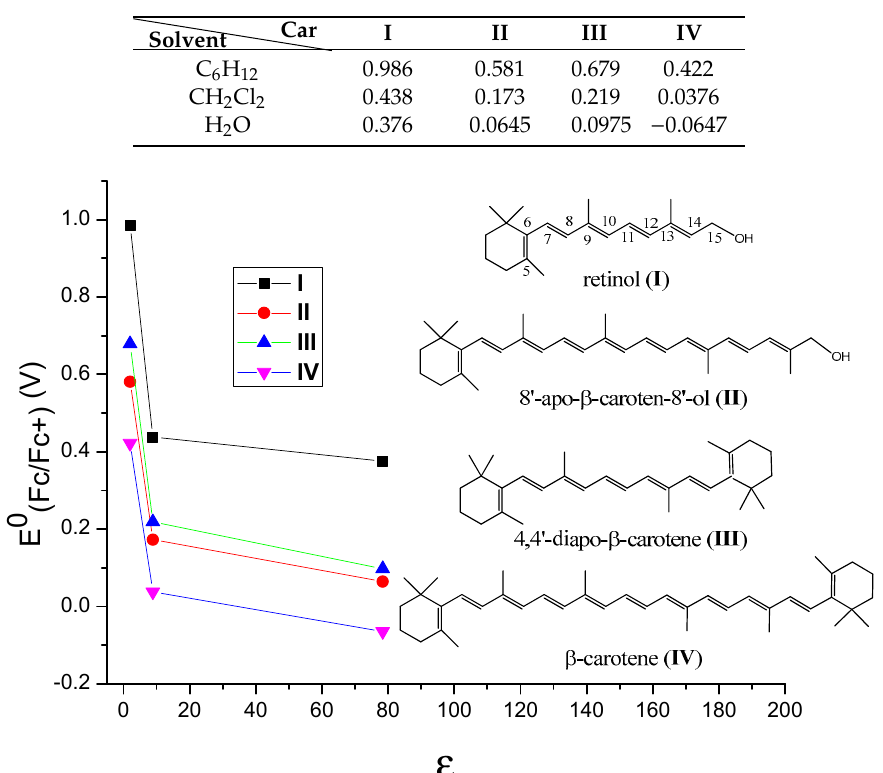
Table 1. Calculated E 0 (Fc / Fc + ) (V) values of the carotenoids in C 6 H 12 , CH 2 Cl 2 and H 2 O.